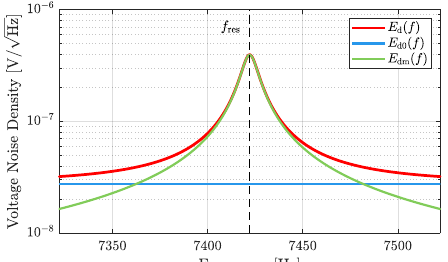
Figure 6. Noise contributions of the sensor to the overall voltage noise density at the output of the differential input transimpedance amplifier for the exemplary sensor described in Table 1, for feedback capacitances of C f = 10pF, and without any excitation signal. Near the resonance frequency, the total noise is dominated by the thermal mechanical noise E dm , whereas the thermal electrical noise E d0 becomes relevant only at some distance from f res